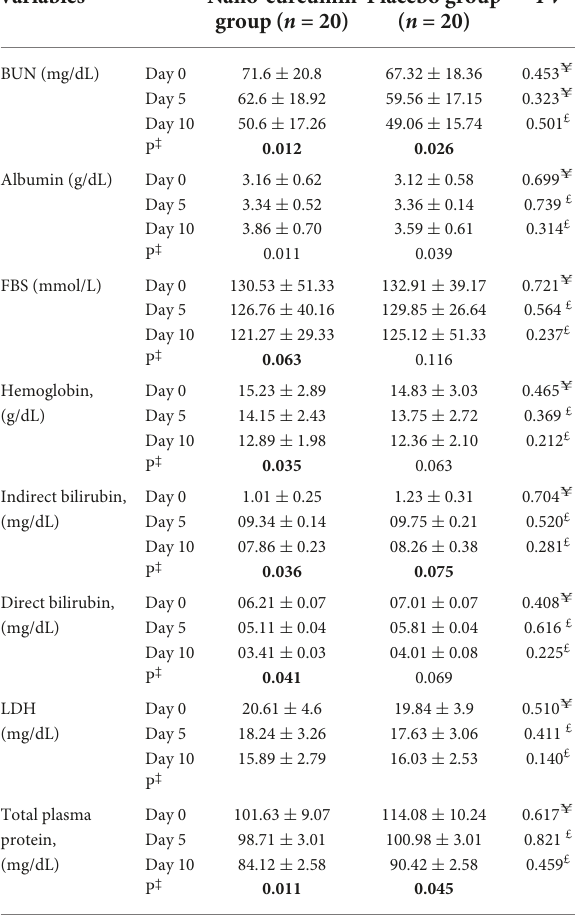
TABLE 5 Effect of curcumin on biochemical factors during the study stages. Variables